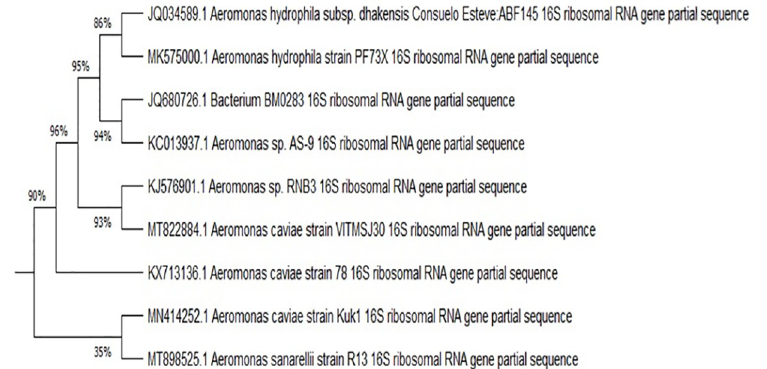
Fig 2. Phylogenetic tree of Aeromonas caviae Kuk1-(34) sp. drawn using UPGMA tree (MEGA X software) with the evolutionary distances showing the relationship of PHB depolymerase producing bacteria with the known sequences of related genera.